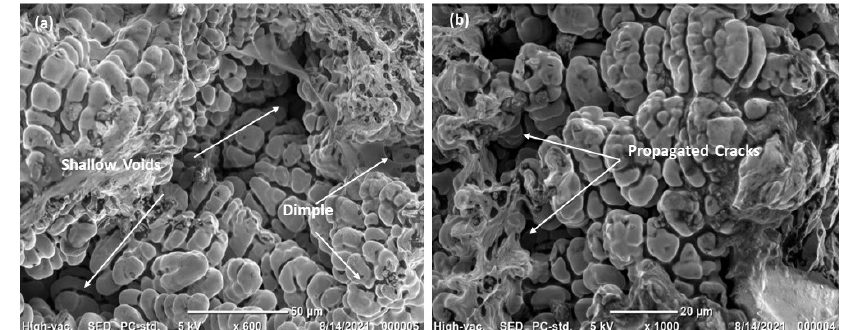
Figure 8: Fractured surfaces of (a) base metal ‘A’ and (b) ASiN composite.